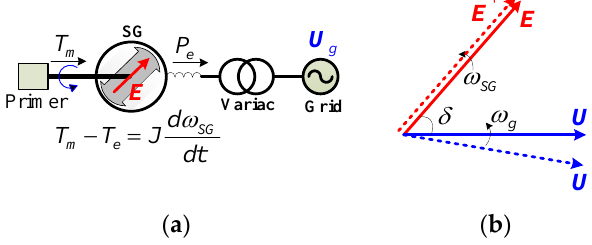
Figure 1. Schematic diagram of SG s’ inner potential. ( a ) Electric diagram; ( b ) Phasor diagram.